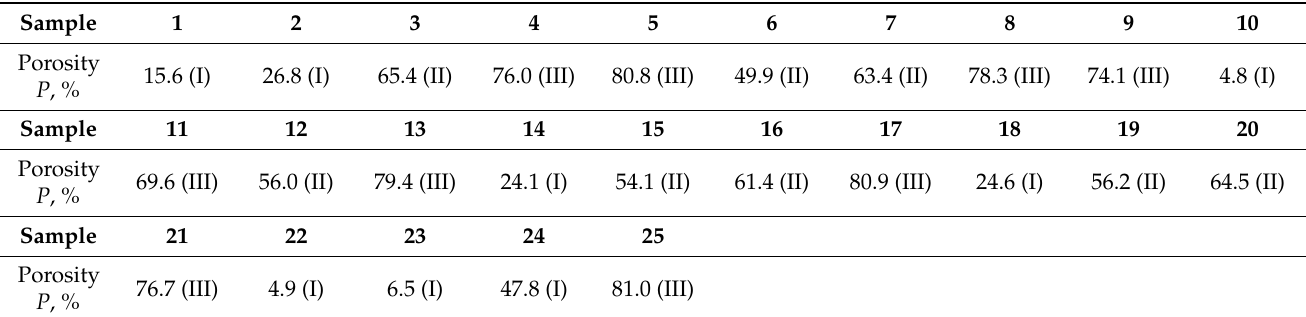
Table 6. Porosity of the foamed samples described in Table 2 as determined using XRM.